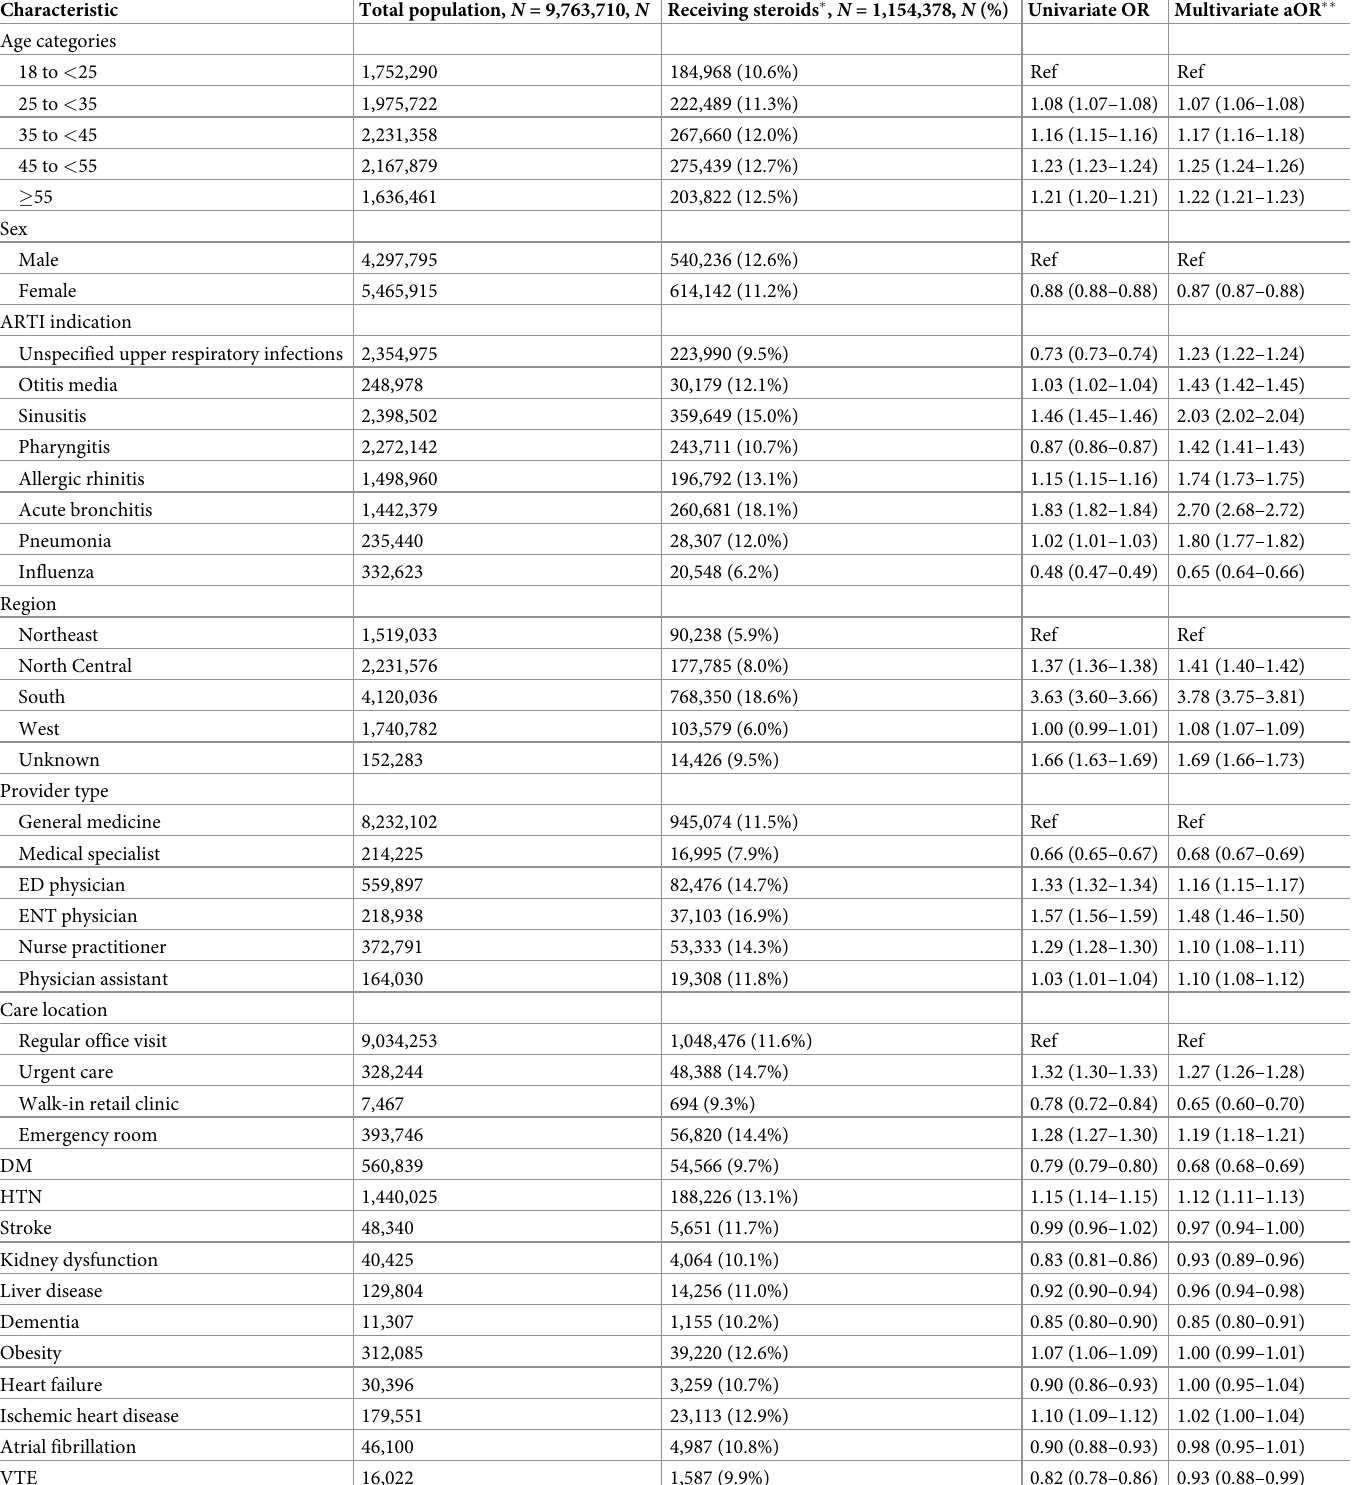
Table 2. Patient characteristics and association with use of systemic corticosteroids.